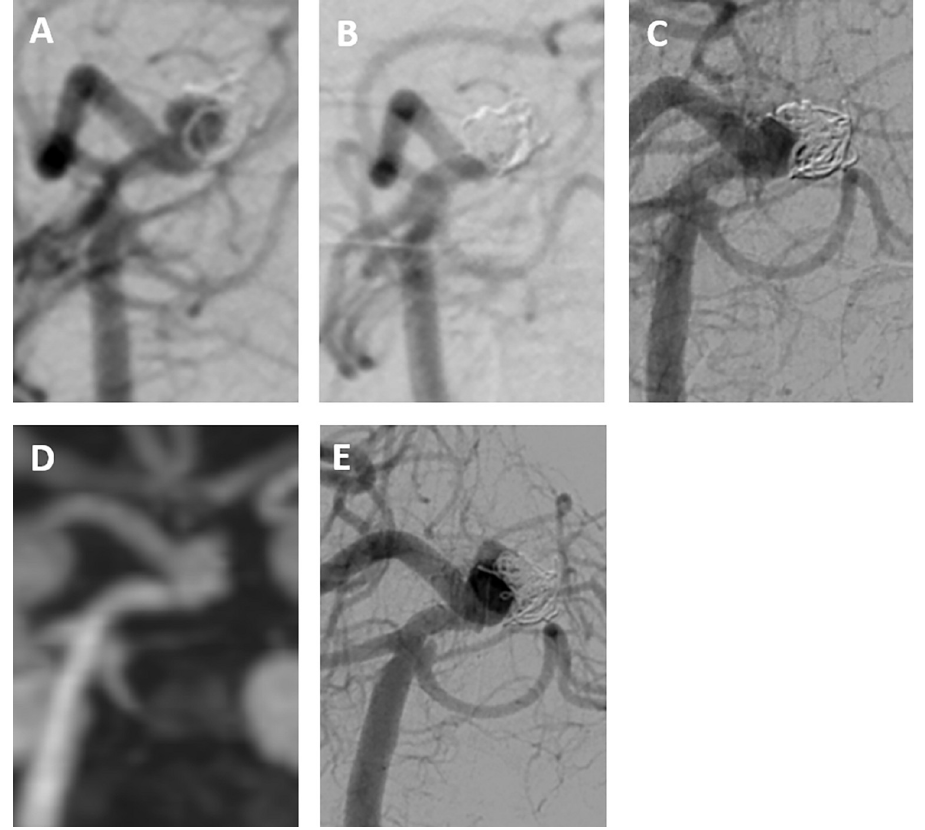
coiling, indicating enlargement of the recurrent neck. (E) Hemorrhage at 7 years after coiling, with angiography indicating the formation of a daughter sac.